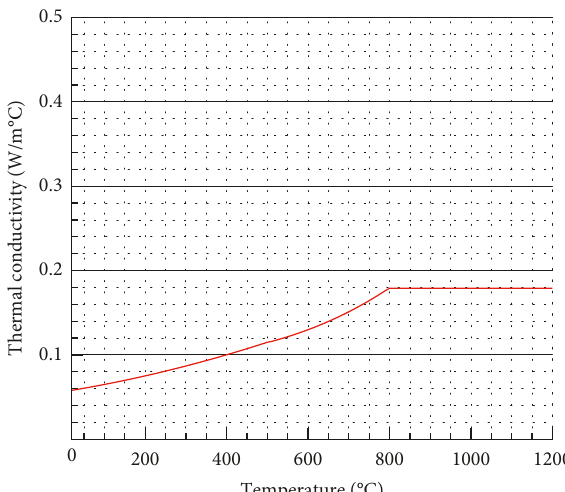
Figure 11: Thermal conductivity for the calcium silicate board at elevated temperatures.